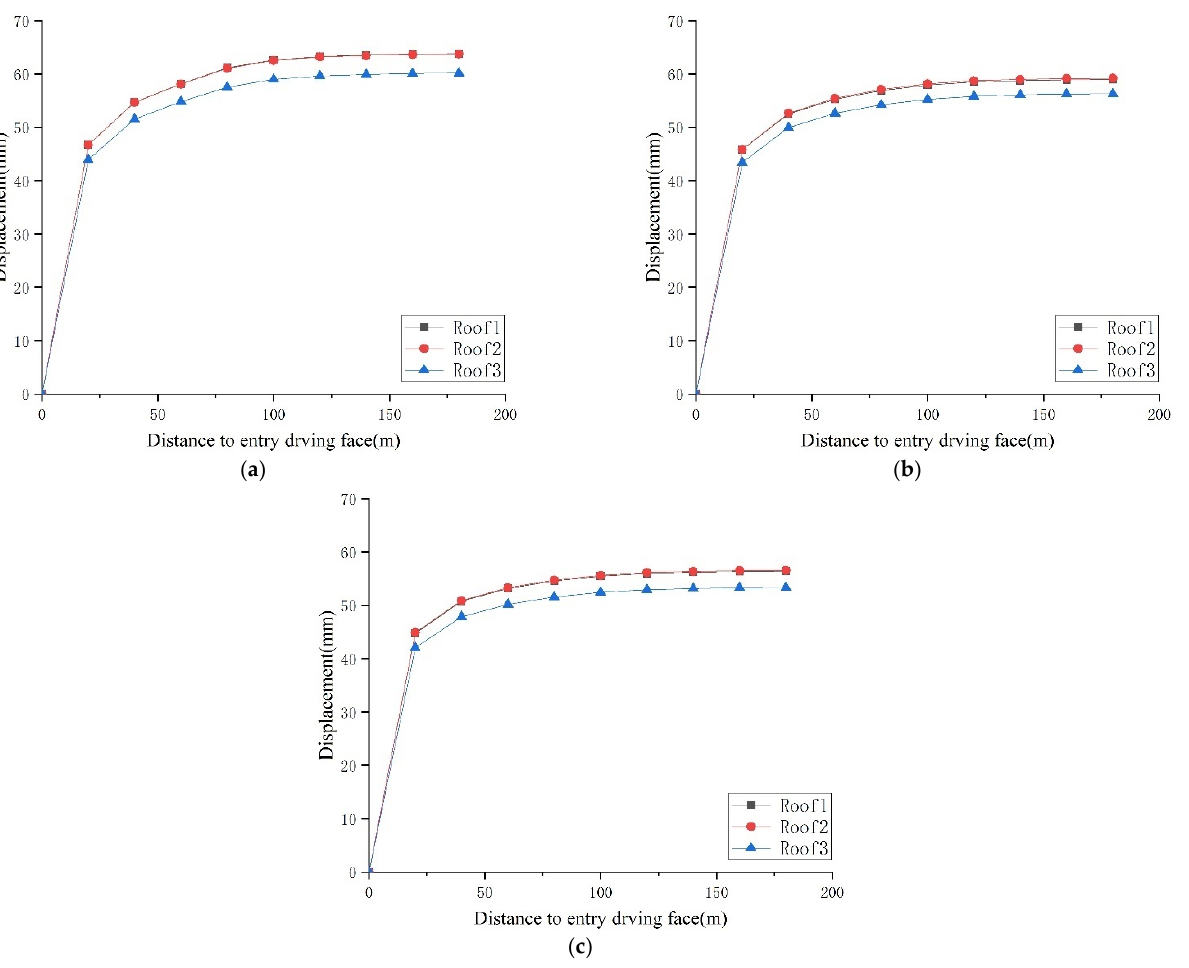
Figure 14. Roof displacement during roadway driving with different yield pillar widths: ( a ) model 4 m; ( b ) model 6 m; ( c ) model 8 m. Table 4. Evolution of average roof subsidence during roadway driving with different yield pillar